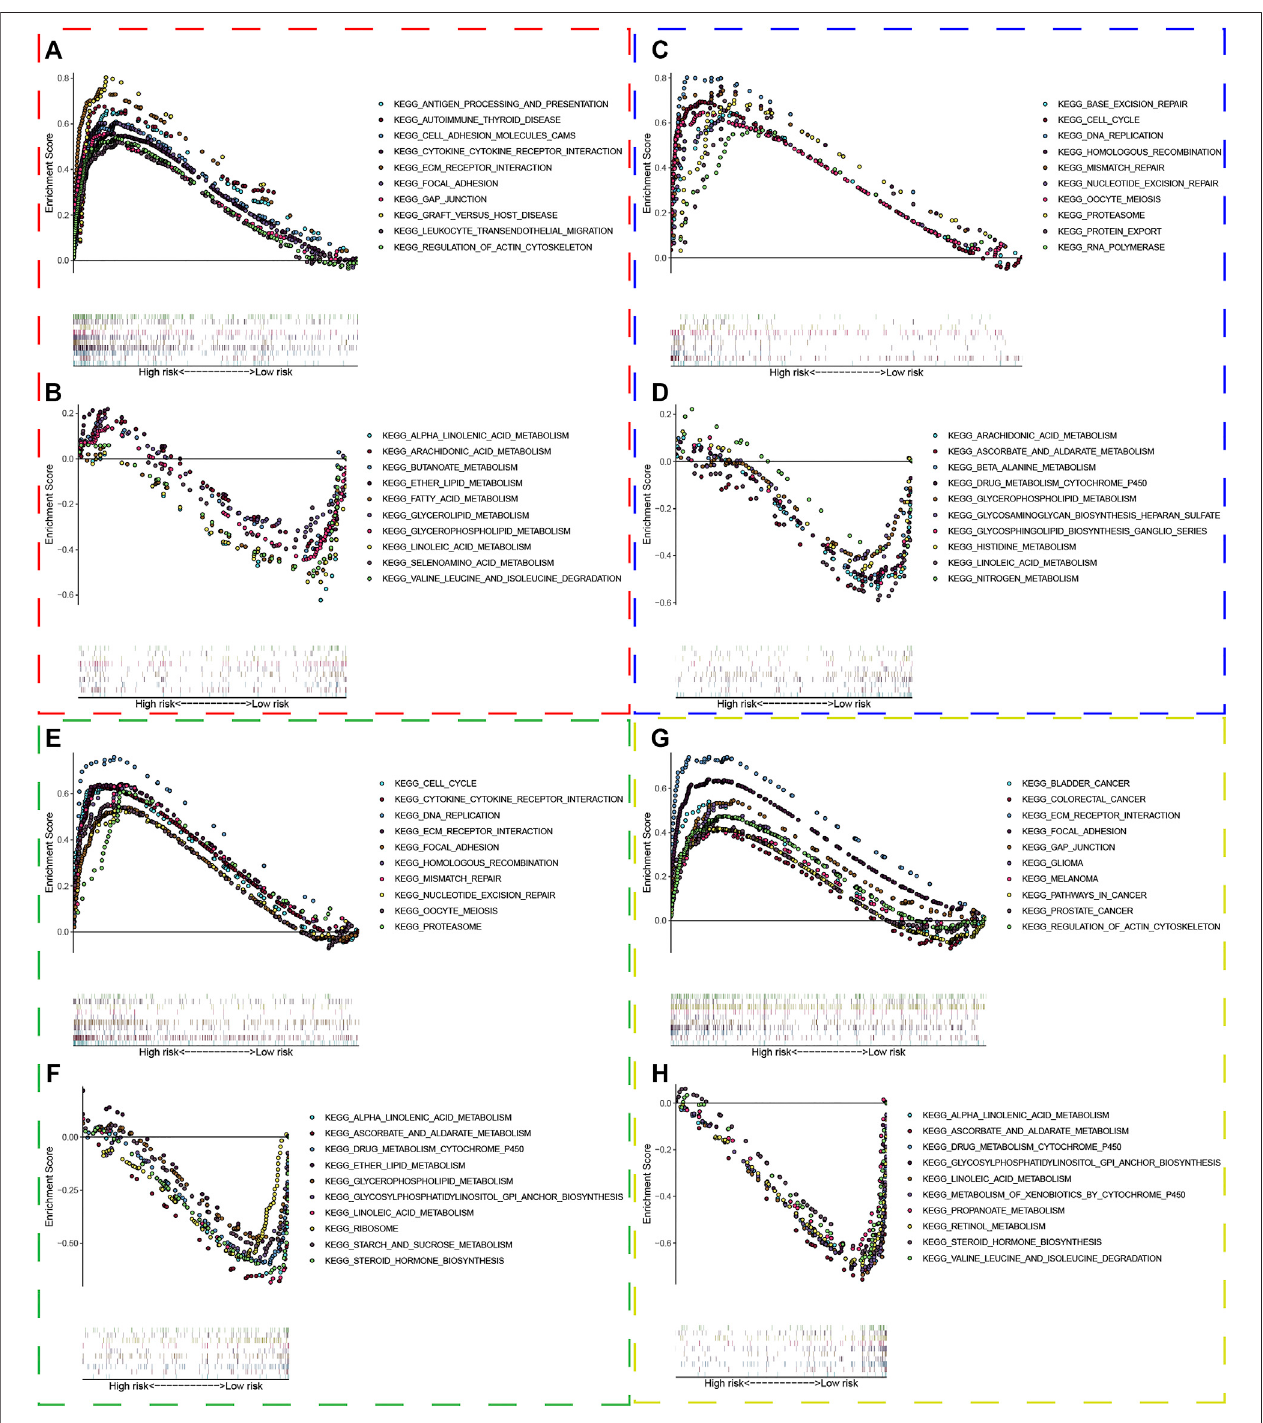
FIGURE 8 | Gene set enrichment analysis. The red, blue, green, and yellow dashed boxes corresponded to the TCGA, GSE13507, GSE32548, and GSE48075, respectively. GSEA results showed signi fi cant enrichment of immune-, extracellular matrix-, replication and repair-related signaling pathways in the high-risk group (A,C,E, and G) , and signi fi cant enrichment of metabolism signaling pathways in the low-risk group (B,D,F, and H) .